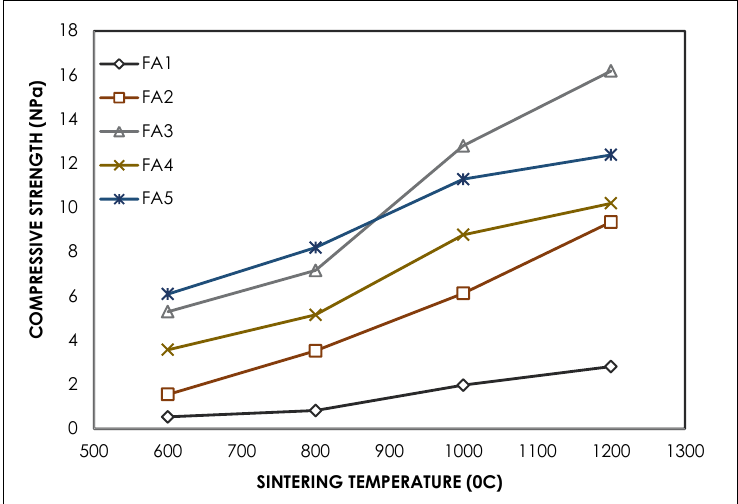
Figure 3: Twelve hours brick strength at various temperature